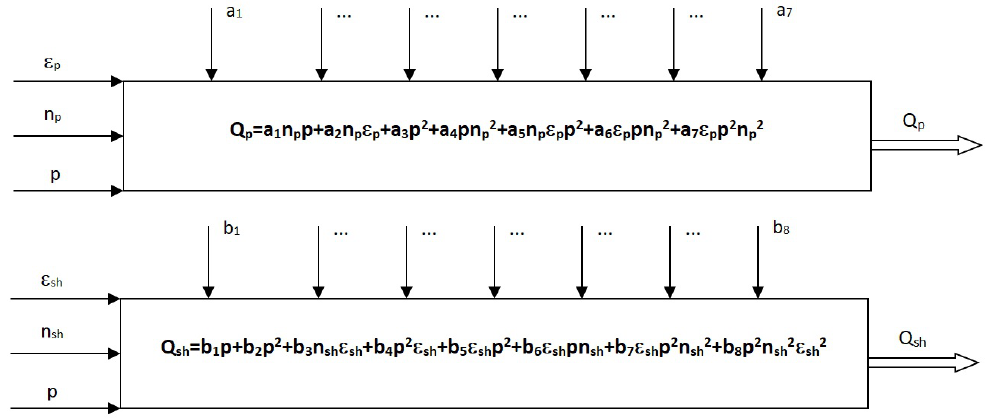
Figure 9. Block diagram of equations for capacity and displacement of hydrostatic pump and engine, where p is the pressure in the system, n p is the rotational speed of the hydrostatic pump, n sh is the rotational speed of the hydrostatic engine, Q p is the capacity of the hydrostatic pump, Q sh is the displacement of the hydrostatic engine and a 1 . . . a 7, b 1 . . . b 8 are constants [2]. The displacement Q a of the hydraulic accumulator is described by the relation shown in the Figure